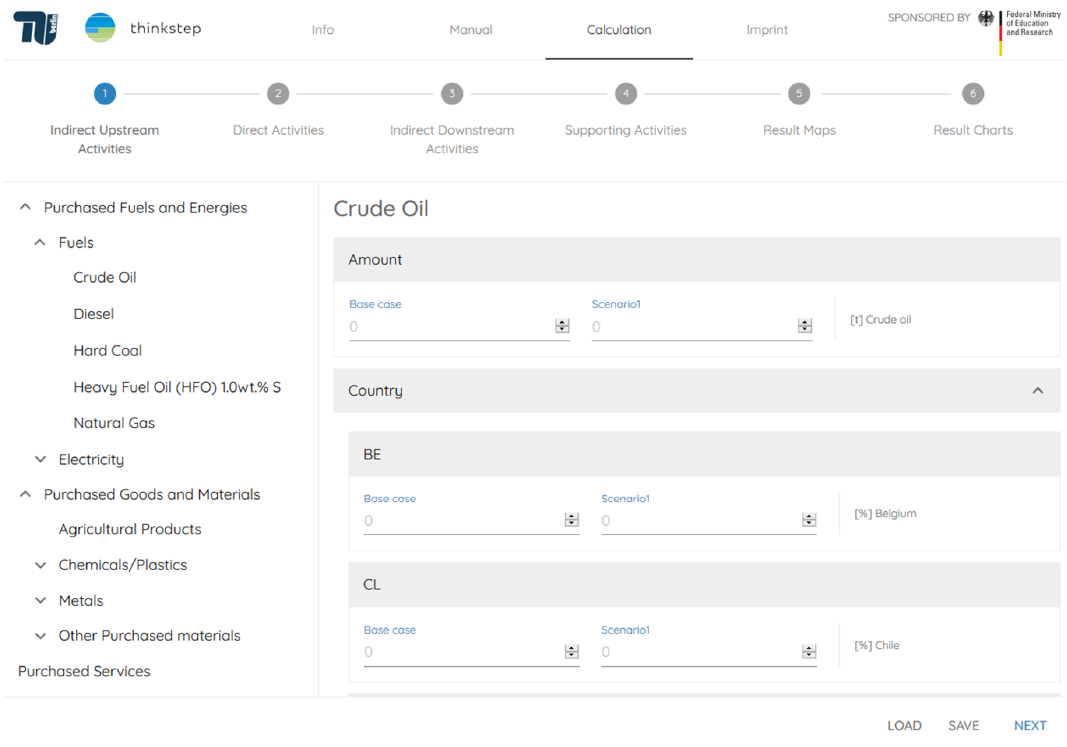
Figure 1. Organizational water footprint (OWF) tool screenshot. The six steps (on the top) and regionalization options for the purchased Crude Oil (indirect upstream activities) are exemplarily shown.